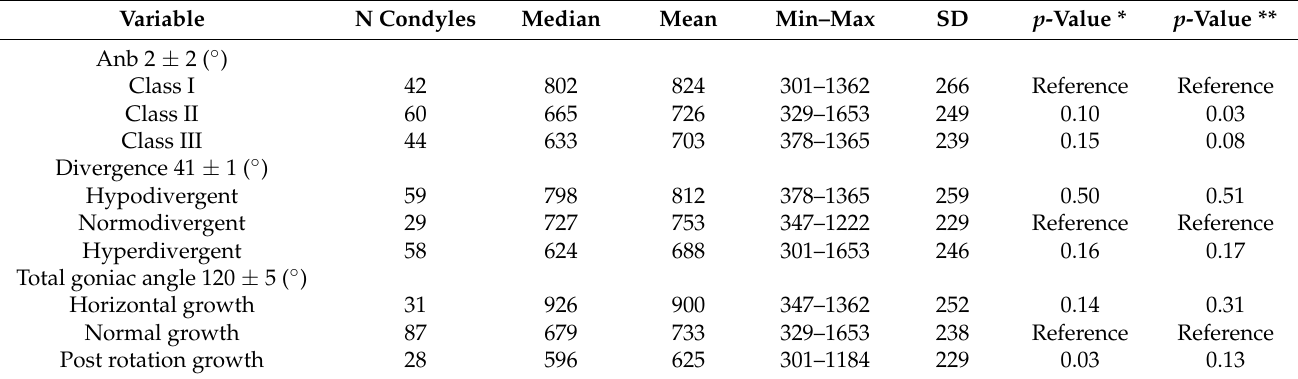
Table 1. Condylar volume values (mm 3 ) in relation to selected, categorized